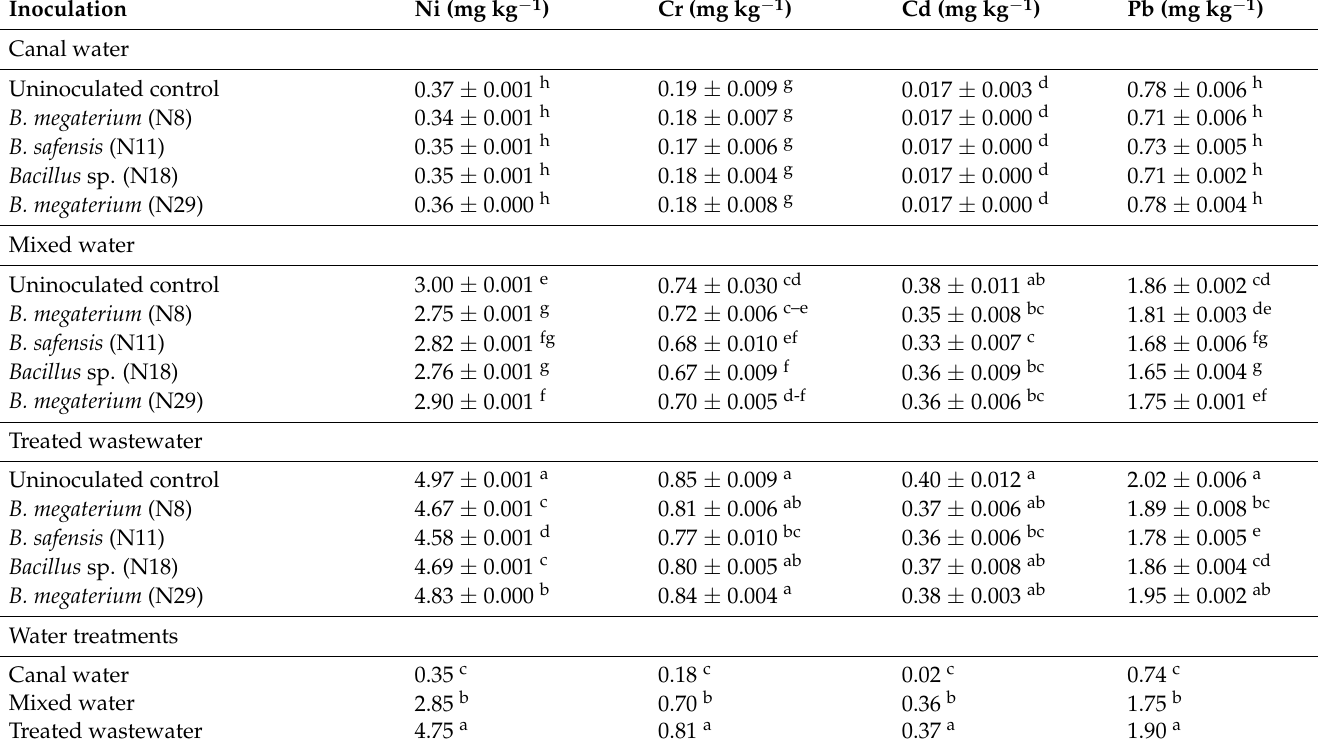
Table 5. Effect of Pb-tolerant Bacillus strains on heavy metal contents of spinach leaves under sewage wastewater, mixed water, and canal water treatments.